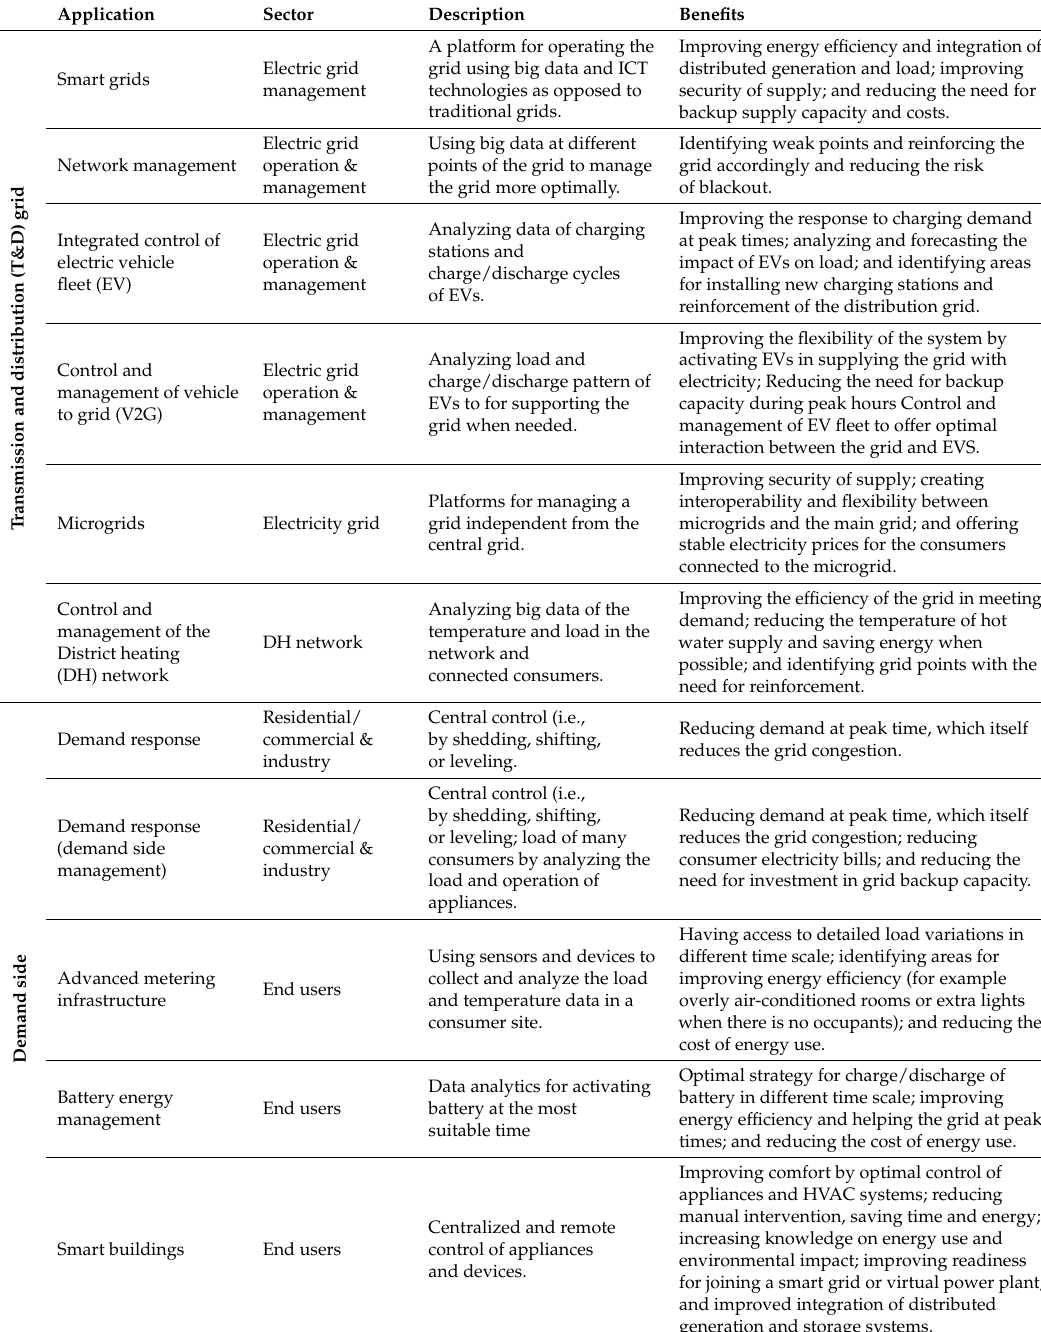
Table 3. Applications of IoT in the energy sector (2): energy grids and demand